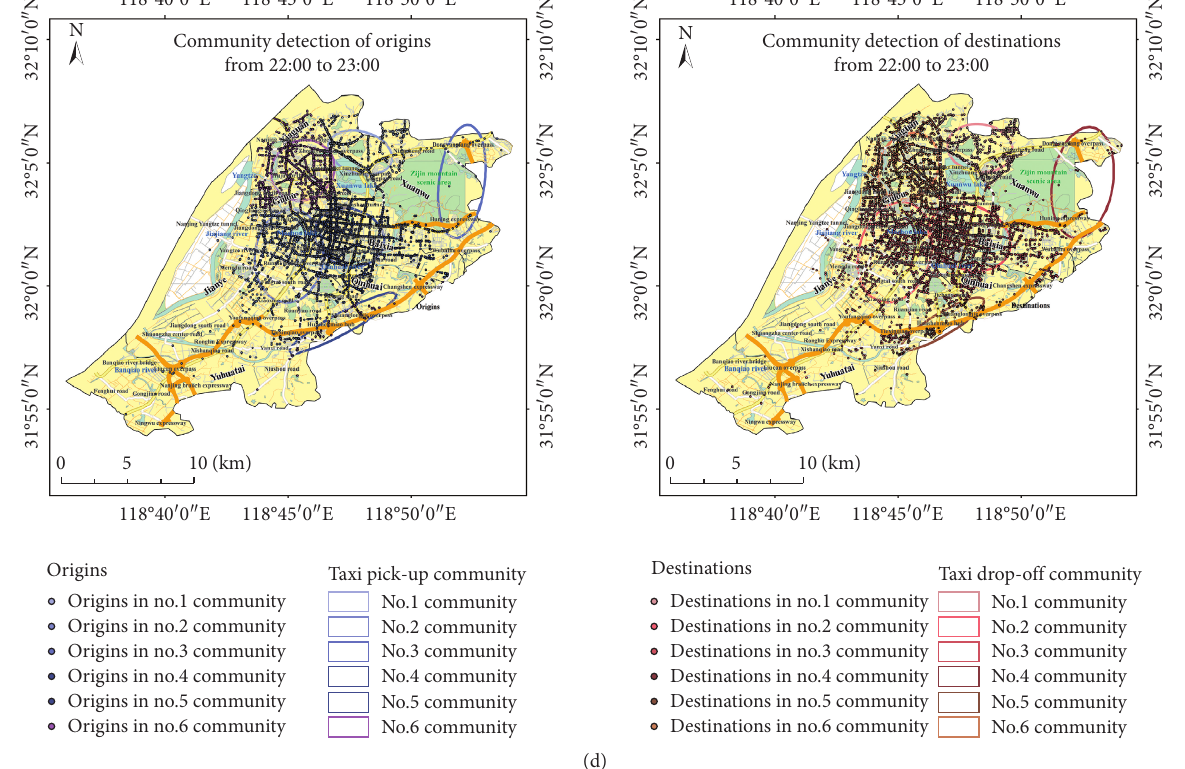
Figure 7: (a) Community detection results of origin and destination from 8:00 to 9 :00. (b) Community detection results of origin and destination from 13: 00 to 14: 00. (c) Community detection results of origin and destination from 18: 00 to 19:00. (d) Community detection result of origin and destination from 22:00 to 23